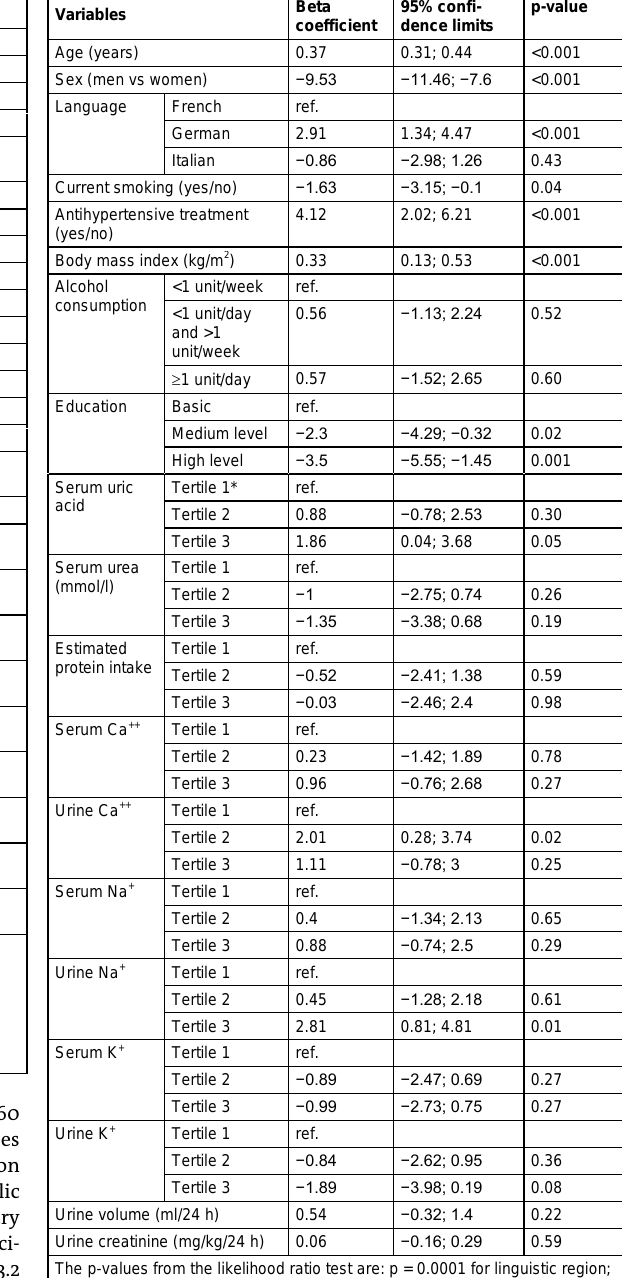
Table 1: Participants’ characteristics by linguistic region (n = 1336). German French Italian